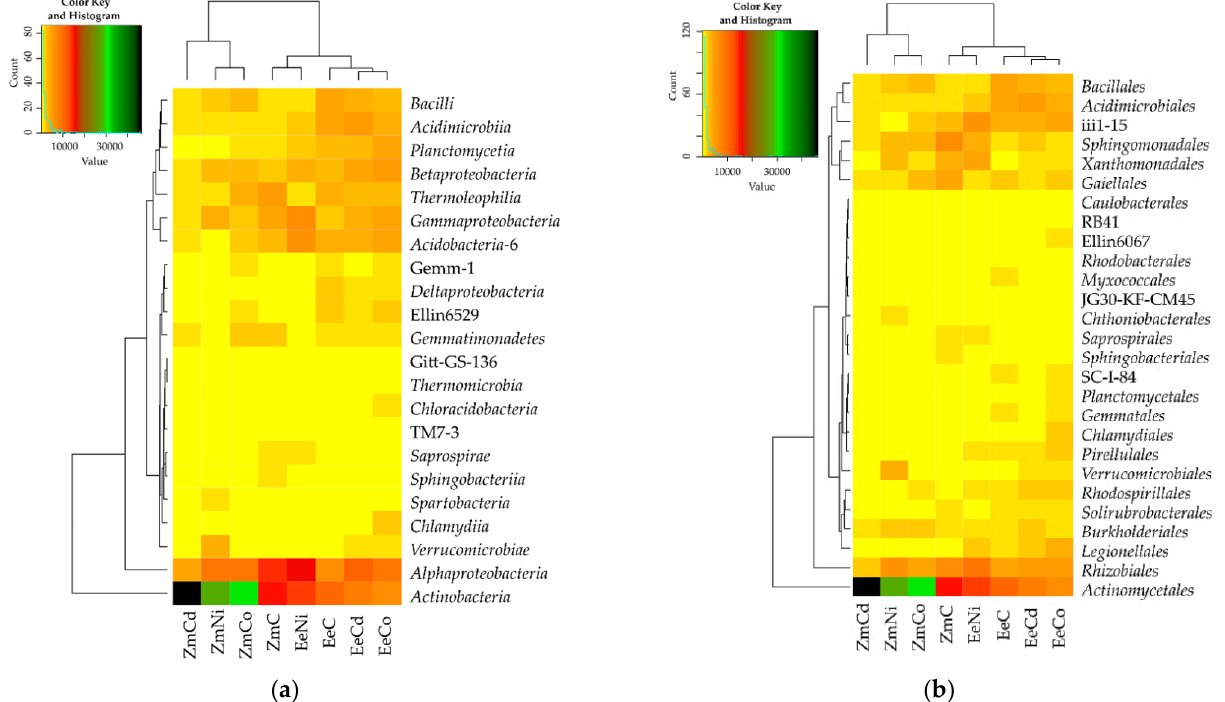
Figure 8. Relative abundance of classes ( a ) and orders ( b ) of bacteria with OTU ≥ 1% in the soil polluted with heavy metals. Ee— Elymus elongatus L.; Zm— Zea mays L.; Org—organotrophic bacteria; Act—actinobacteria; Fun—fungi. C—control soil;